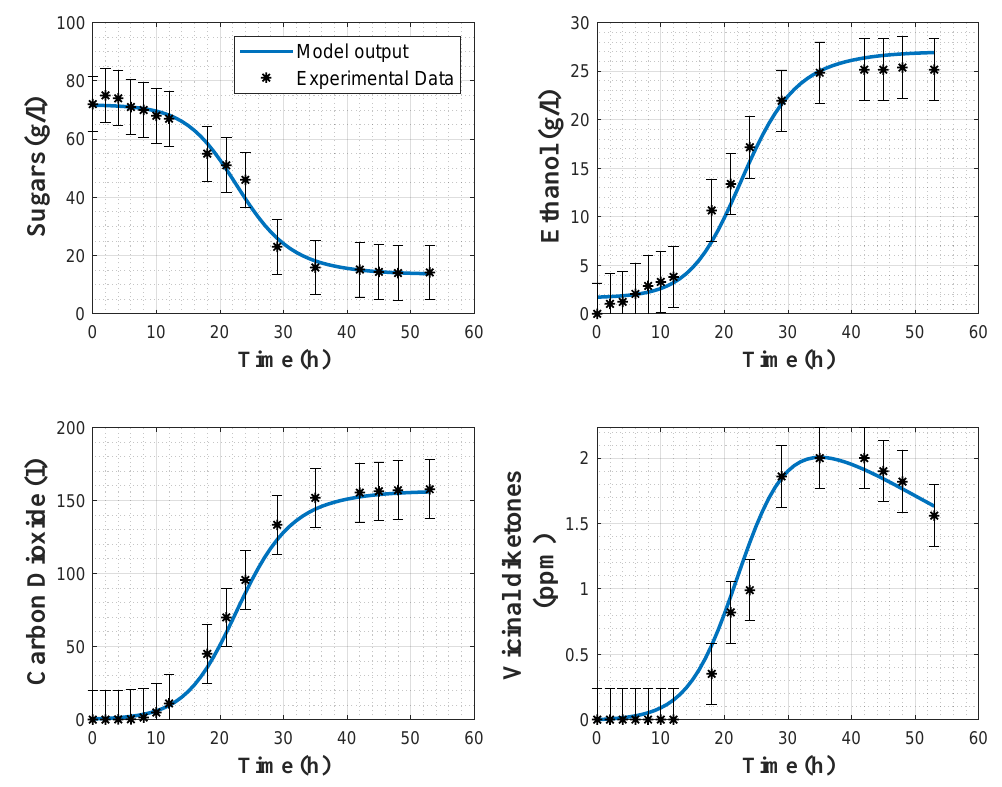
Figure 5. Direct validation of the carbon dioxide model with the data from experiment 2. Stars: experimental data. Error bars: 95% confidence intervals. Continuous blue line: model